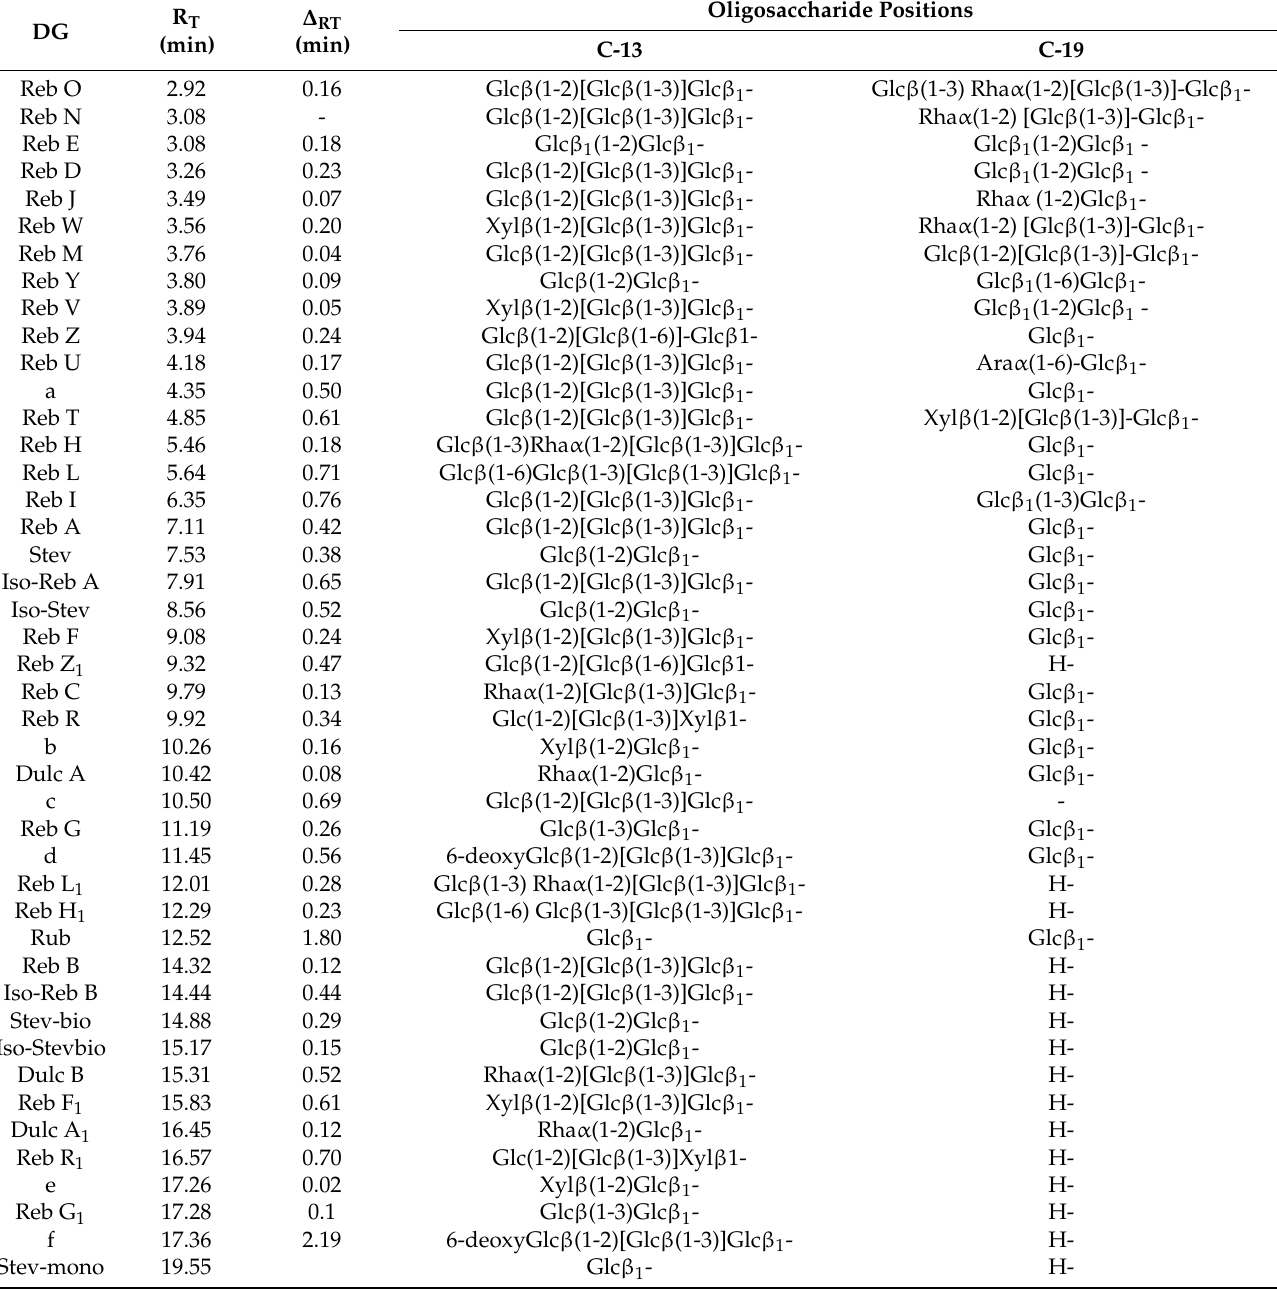
Table 3. Diterpene glycosides organized by increasing retention times in an RP-C18 HPLC